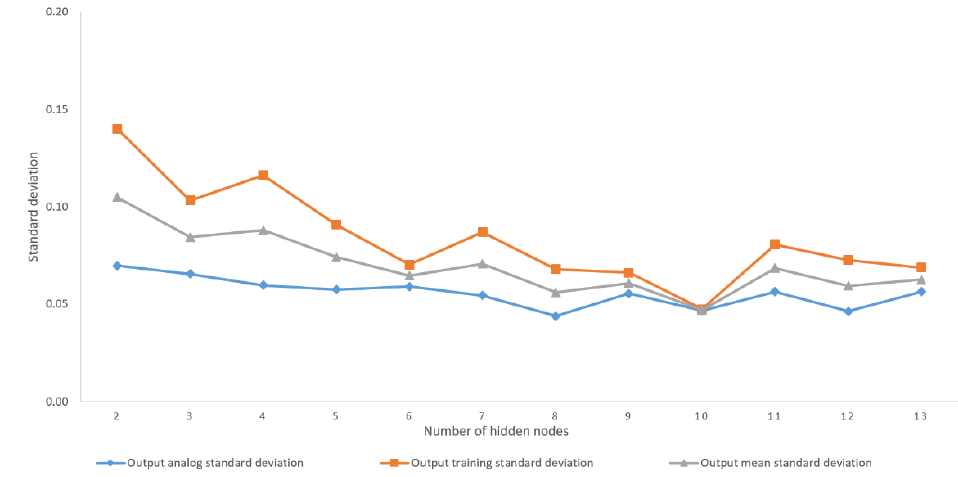
Figure 11. The effect of hidden layer nodes on the prediction effect.